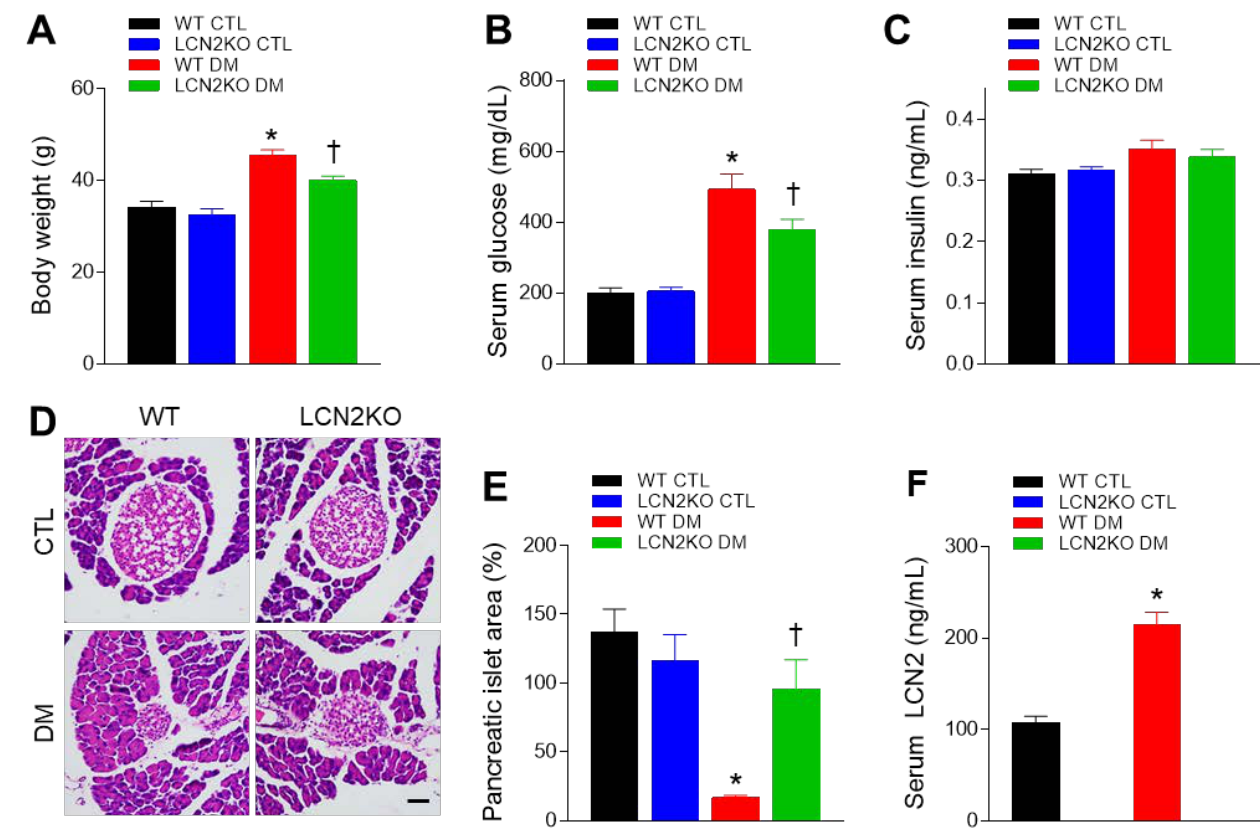
Figure 1. Effects of LCN2 deletion on insulin resistance in HFD/STZ-induced diabetic mice: ( A ) body weights, ( B ) fasting serum glucose levels, and ( C ) serum insulin levels for each group; ( D ) repre- sentative images showing H&E-stained pancreatic sections; scale bar = 50 µm; ( E ) pancreatic islet areas measured for each group; ( F ) serum LCN2 levels measured for each group. CTL: control; DM: diabetic mice. Data are presented as the mean ± SEM. The indicated p -values represent a two-way ANOVA, followed by Tukey’s post hoc test. * p < 0.05 vs. WT CTL. † p < 0.05 vs. WT DM.